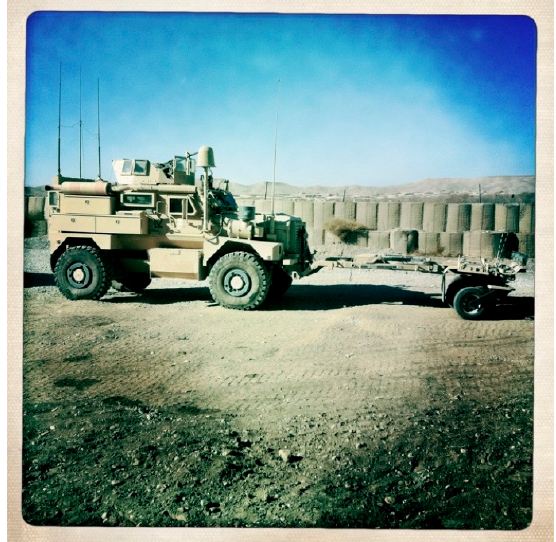
Figure 3. Mine Resistant Ambush Protected Vehicle. Source: created by Rita Leistner (used with photographer’s permission).